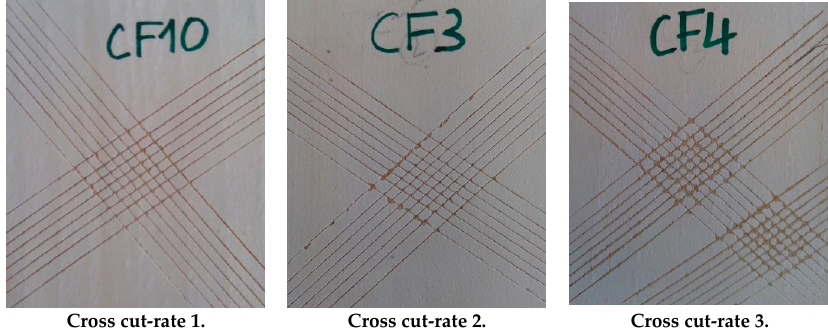
Figure 1. Cross-cut adhesion of CF3, CF4 and CF10. Rate 1 is generally well accepted for commercial organic coatings. Relatively poor adhesion values were measured for the high solid content (CF6) formulation and for for- mulations with added glycerol, xylose and sucrose (pull-off adhesion lower than 2 MPa and cross-cut results of 2 to 5). The adhesion was higher with dextrin (CF5) than with other sugars and glycerol. The decrease of the modulus of water glass to 1.5 and 0.5